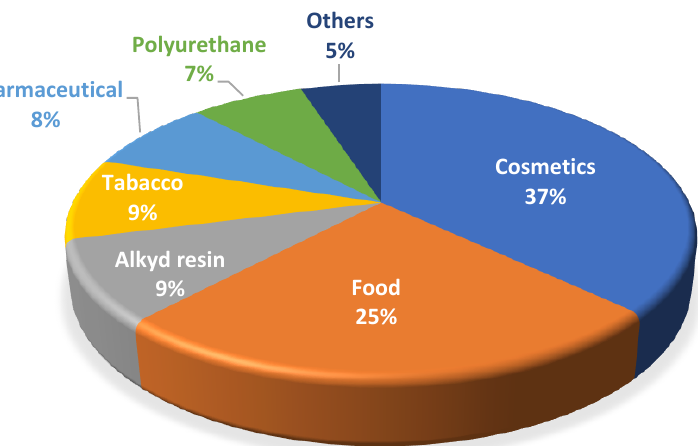
Figure 1. Distribution of the main glycerol applications [9].